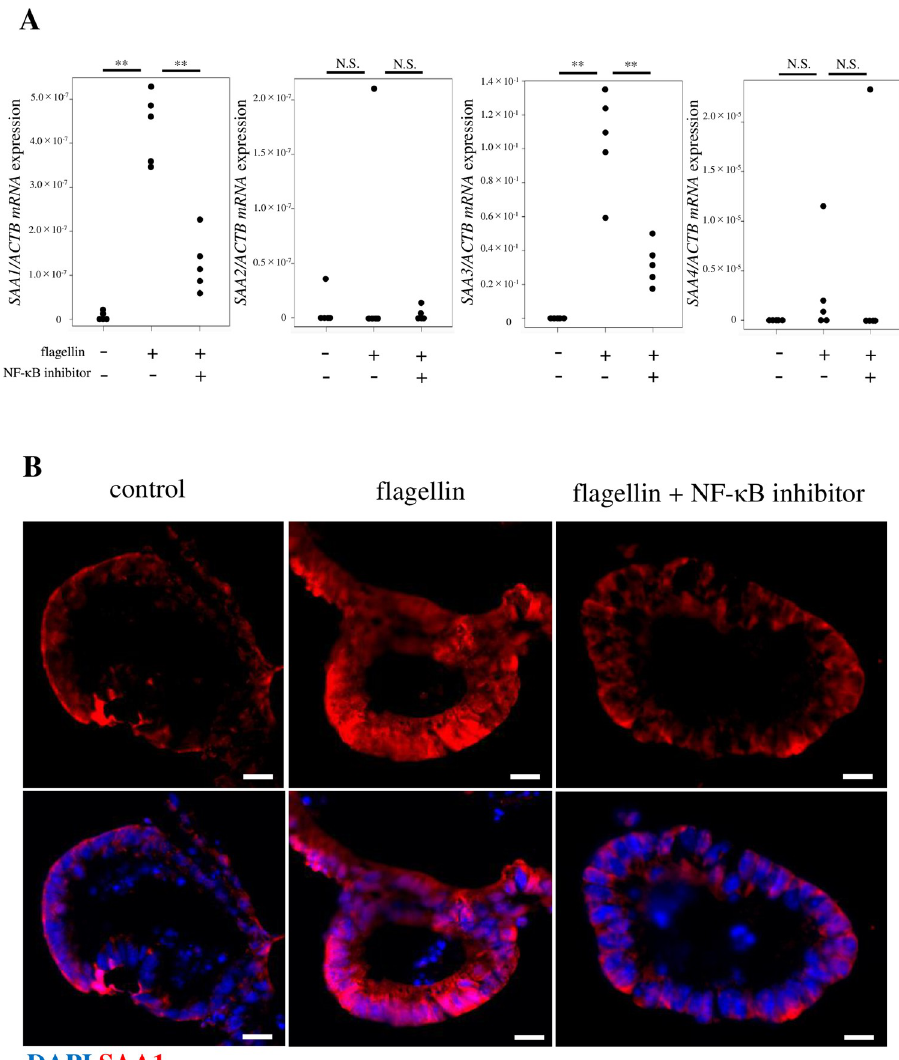
Fig 3. Flagellin promotes SAA1-4 expression in small intestinal organoids via NF- κ B. (A) Normalized SAA expression levels in small intestinal organoids upon stimulation with Toll-like receptor ligands flagellin (10 μ g/mL) for 3 h. The addition of flagellin significantly increased the expression level of SAA1/3 , an effect that was inhibited by NF- κ B inhibitor BAY11-7082 (20 μ M). SAA expression level was normalized to that of ACTB and is represented as the mean ± standard deviation (n = 5). �� P < 0.01. (B) Immunostaining of mouse small intestinal organoids confirmed that flagellin enhanced SAA1 levels. This effect was suppressed in the presence an NF- κ B inhibitor. All samples were photographed under the same conditions. Negative controls were also photographed under the same conditions (exposure time, etc.) to confirm the absence of autofluorescence. Scale bar, 10 μ m. B (I κ B)- α and p100. However, upon receiving the activation signal, inhibitory proteins are degraded, while NF- κ B is activated and translocates into the nucleus where it functions as a transcription factor [28]. In fact, the I κ B protein degradation was observed after 30 min of fla- gellin stimulation of small intestinal organoids (Fig 4B). The protein expression level of I κ B was then increased at 3 h after flagellin stimulation, which may be because I κ B is restored at 2 h, as previously reported [27]. In addition, sulfasalazine reportedly represses I κ B α gene expres- sion [29], and the protein expression of I κ B α was also repressed by 5-ASA in the present study